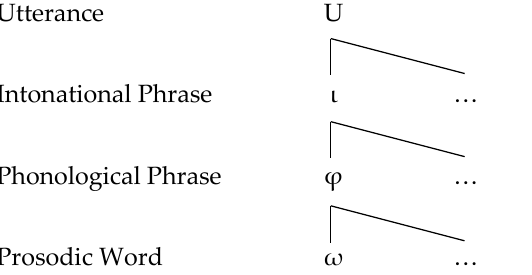
Figure 1. Domains of the prosodic hierarchy, showing only the Prosodic Word and above (adapted from Bonet 2020, p. 333; see also Selkirk 1978, 1984, 1986; Nespor and Vogel 1986). Analyzing prosodically based continuity lenition of the voiced stops /b/ , /d/ , /ɡ/ in U.S. Spanish of Colombian heritage, Lozano (2021) reformulates (11) so as to define inten- sity thresholds according to a consonant’s position within a specified prosodic domain: